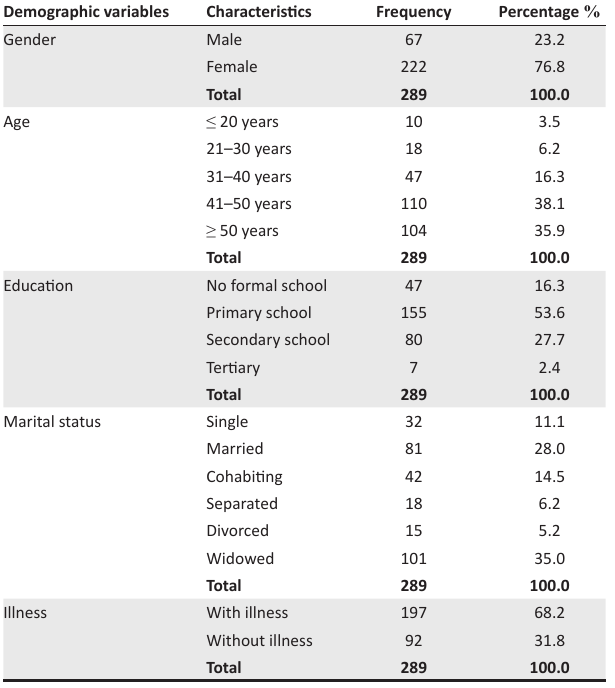
TABLE 1: Demographic characteristics of persons on HAART ( n = 289).